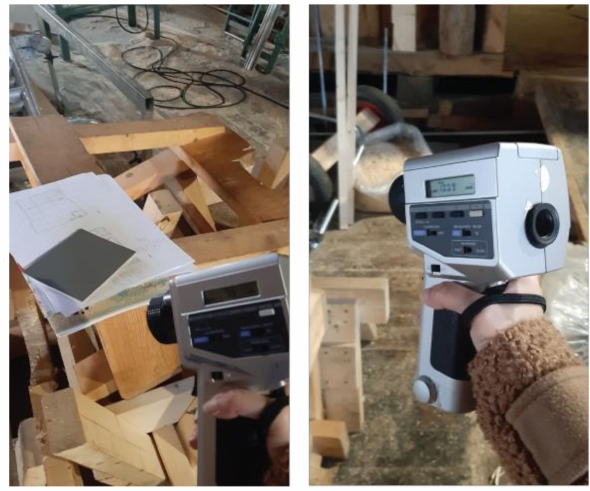
Figure 5. Field luminance measurement is used to calculate the light reflectance of real materials for simulations